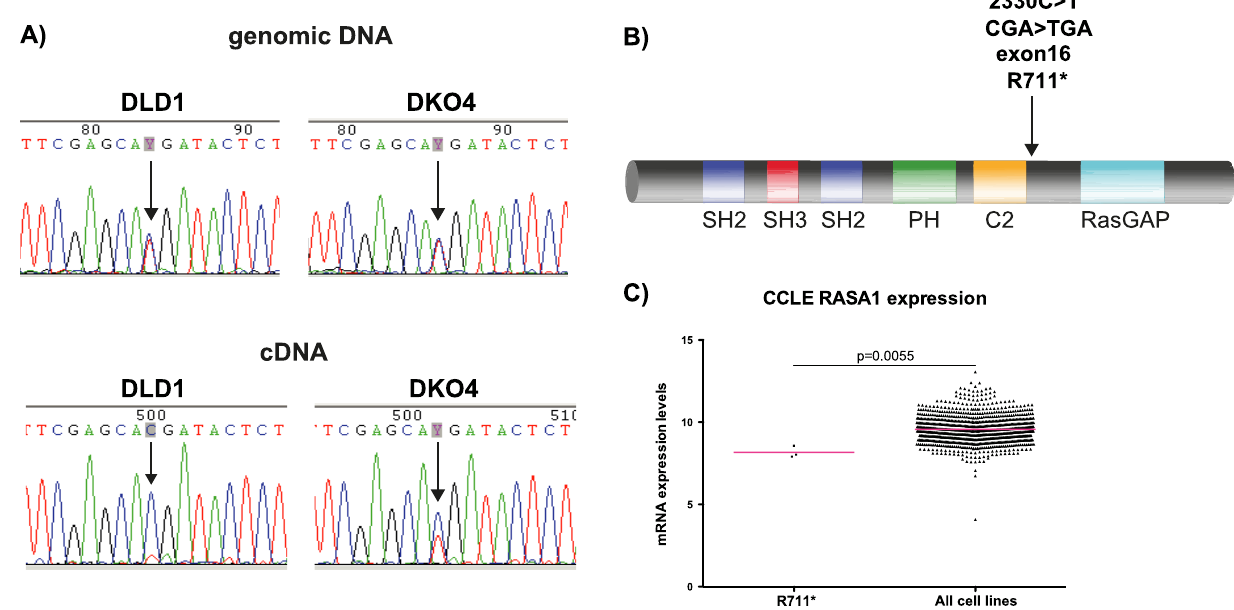
Figure 2. Identification of a novel truncating mutation in RASA1. A) Chromatogram showing relative intensities of each base pair after Sanger sequencing in both the genomic and cDNA derived from the cell lines. B) Illustration of location of the mutation at the RasGAP protein level. C) RASA1 expression data derived from all cell lines in the Broad Institute Cancer Cell Line Encyclopedia. Bars represent mean.